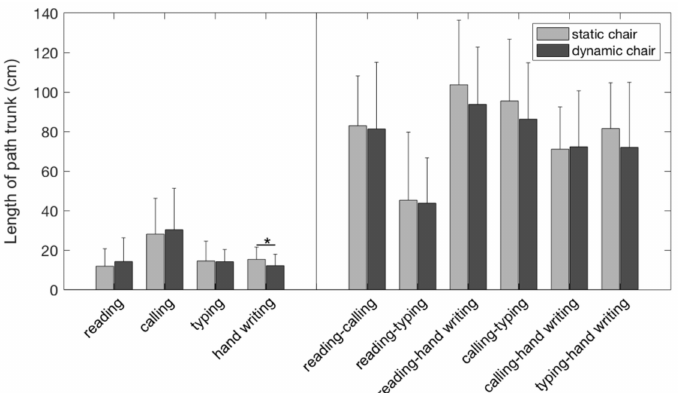
Figure 4. Length of path of the trunk motion during the different tasks and task transitions while sitting on the dynamic (dark grey) and static chair (light grey). The asterisk indicates (*) significant differences between the chair conditions ( p <